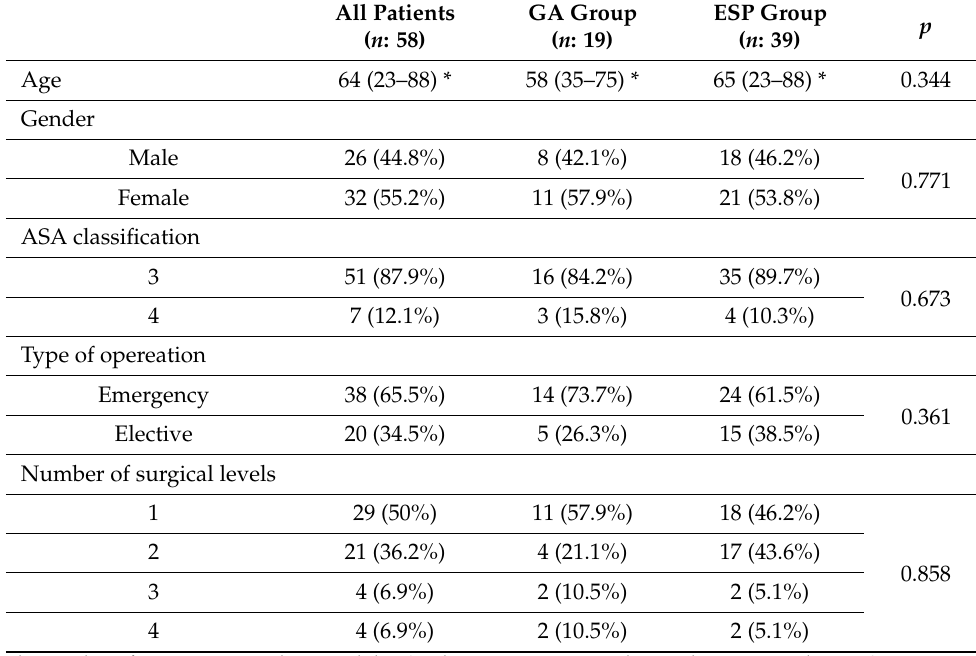
Table 1. Data of study